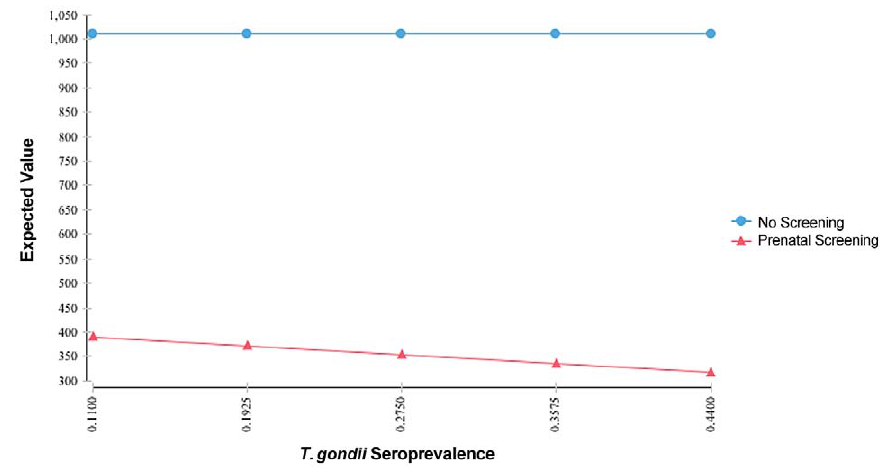
Figure 7. Sensitivity analysis on T.gondii seroprevalence.